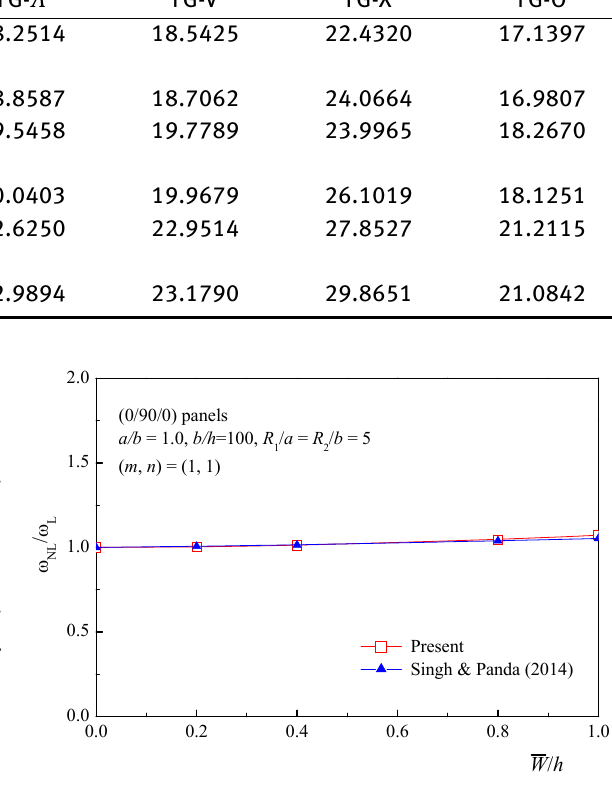
Figure 2: Comparisons of frequency-amplitude curves of a (0/90/0) laminated square spherical panel